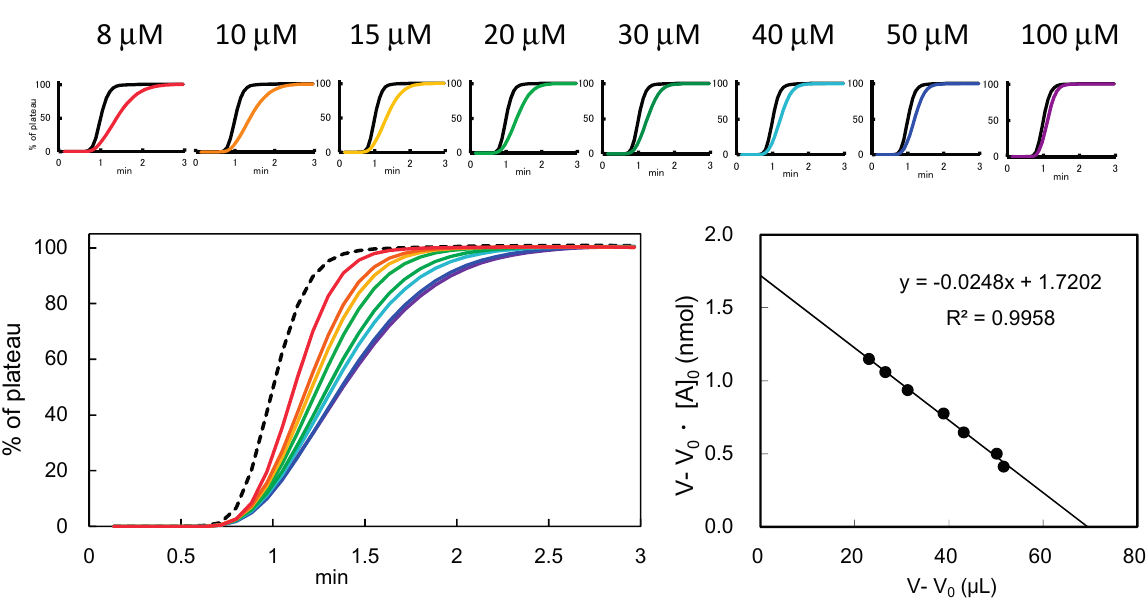
Figure 4. A typical case of concentration-dependency analysis using an ECA